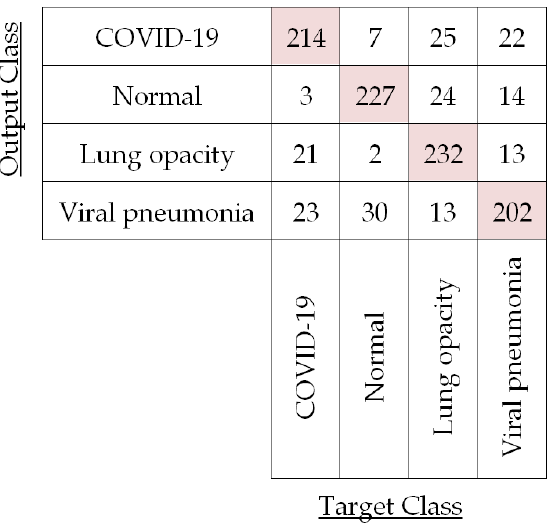
Figure 12. Confusion matrix for the test CXR images in first fold (Fold 1) using LBP ‐ based SVM. Table 4. Classification performance for the test CXR images in Fold 1 using LBP-based SVM. Class Accuracy (%) Precision (%) Recall (%) Specificity (%)